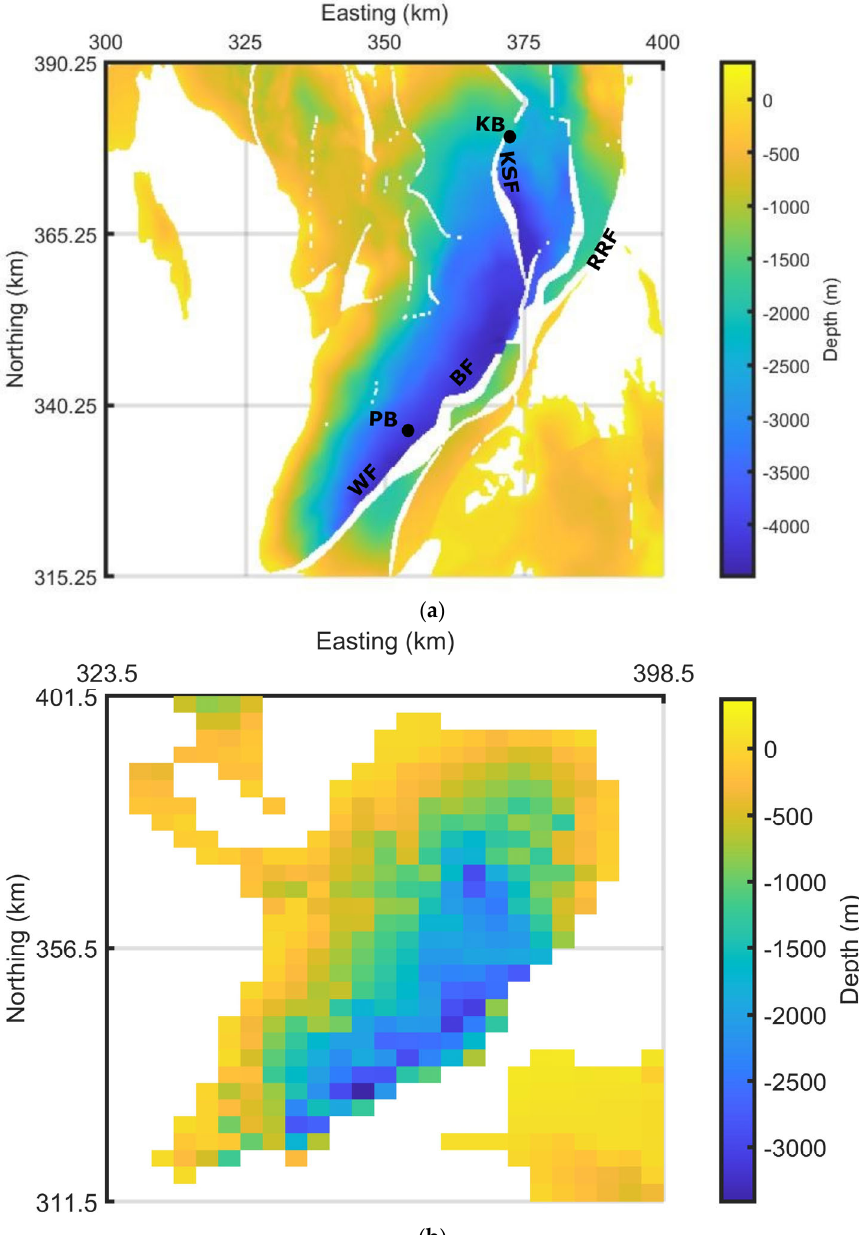
Figure 3. ( a ) Depth map to the base of the Cheshire Basin. Resolution of 250 m spacing. Derived from South West Pennines Model, Lithoframe 3D model—250K data, 13,160 km 2 scale BGS Digital Data under License 2022/067 ‐ V2 British Geological Survey © and Database Right UKRI. All rights reserved [58]. ( b ) Depth map of the base of Triassic sandstones. Resolution of 3 km spacing. Contains British Geological Survey materials Copyright NERC 2022 [59]. Note borehole localities shown as black circles. Abbreviations as follows: PB = Prees ‐ 1 borehole, KB = Knutsford ‐ 1 borehole, WF = Wem Fault, BF = Bridgemere Fault, KSF = Kings Street Fault and RRF = Red Rock Fault. See Plant et al. [23] for further structural features. For location of the map see area highlighted in Figure 1.